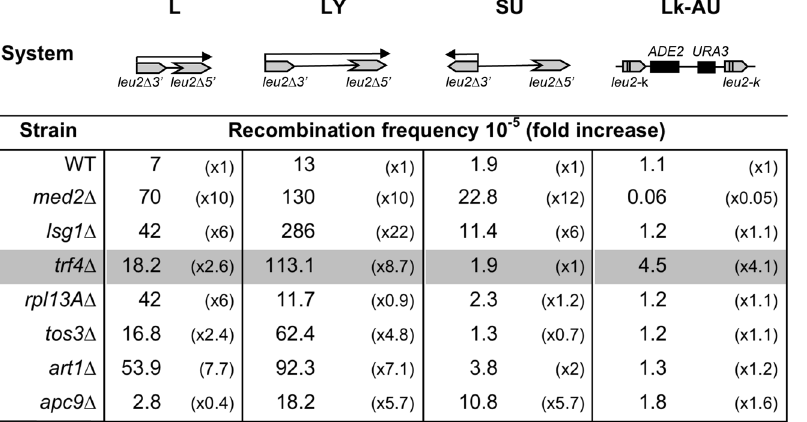
Figure 1. Recombination analyses of med2 , lsg1,trf4,rpl13A,tos3,art1andapc9 mutants. A diagram of each recombination system (not drawn to scale) is shown at the top. Repeats are shown as gray boxes. Arrows indicate relevant transcripts produced by the constructs. For the L, LY and SU systems, recombination frequencies were determined in wild-type (FY1679) and mutant strains transformed with plasmids pRS314-L and pRS314-LY carrying the leu2 direct-repeat systems, and pRS314-SU carrying an inverted repeats system. Recombinants were selected as Leu + . The average median value and SD of 3–4 fluctuation tests are shown. Recombination frequencies of med2 D (MGY1-2D ) , lsg1 D (AFGL-7D), trf4 D (AWT4-1C), rpl13A D (WFDL-1D), tos3 D (AFGL-2D), art1 D (AFOR-1A), apc9 D (WFLR-2B) and wild-type ( MGY6-1A ) congenic strains carrying the chromosomal leu2- k :: ADE2-URA3 :: leu2-k system are shown. For recombination analyses, independent colonies were obtained from SC and recombinants were selected in SC +